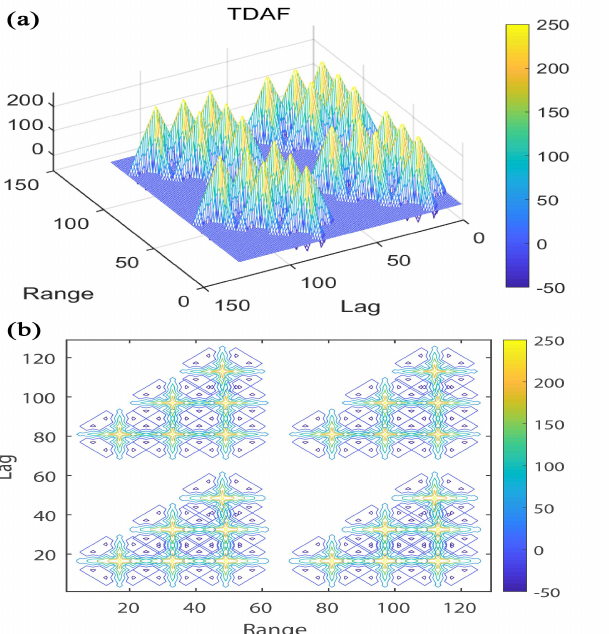
Figure 2. ( a ) TDAF of 4-bit strong alternating code modulated by 4-bit complementary code and ( b ) corresponding contour plot.